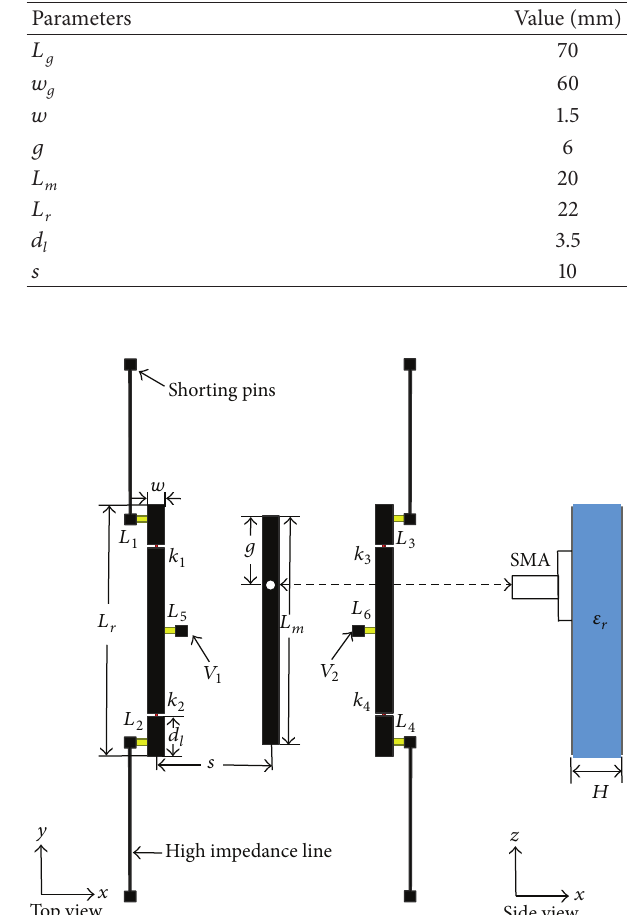
Table 1: Parameter for pattern reconfigurable antenna.